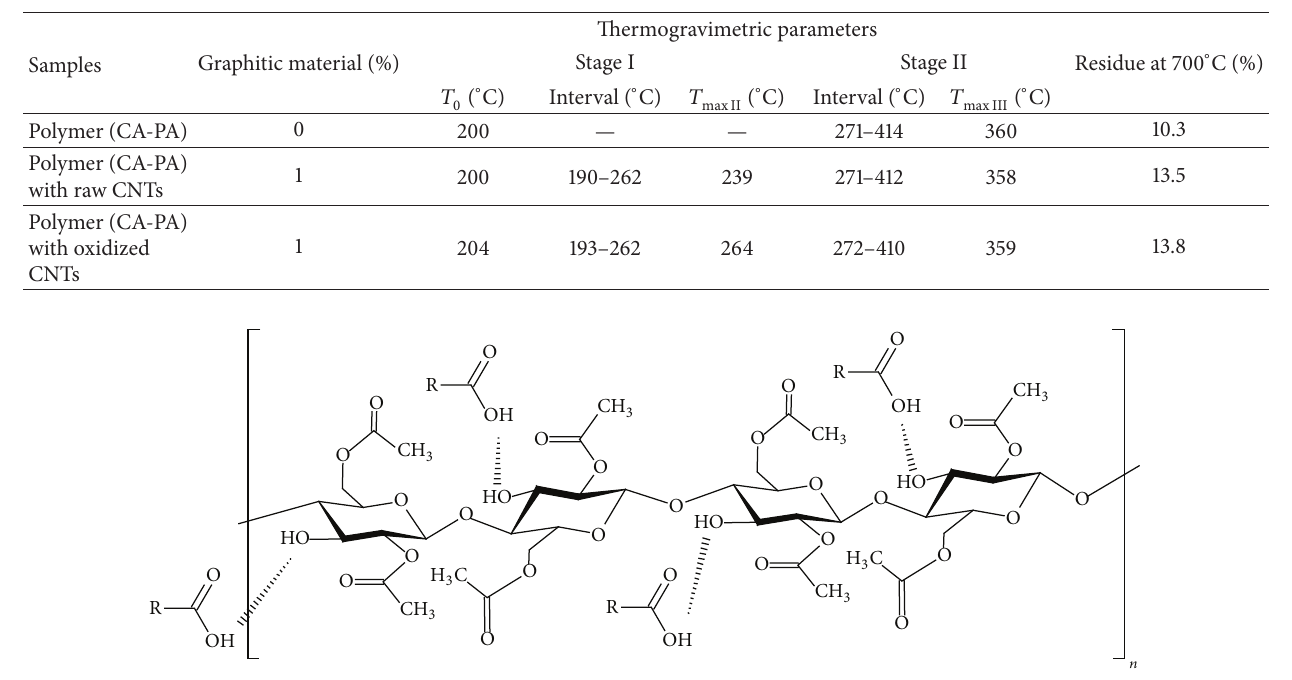
Table 1: Thermal parameters of polymer (CA-PA) with raw and oxidized CNTs.